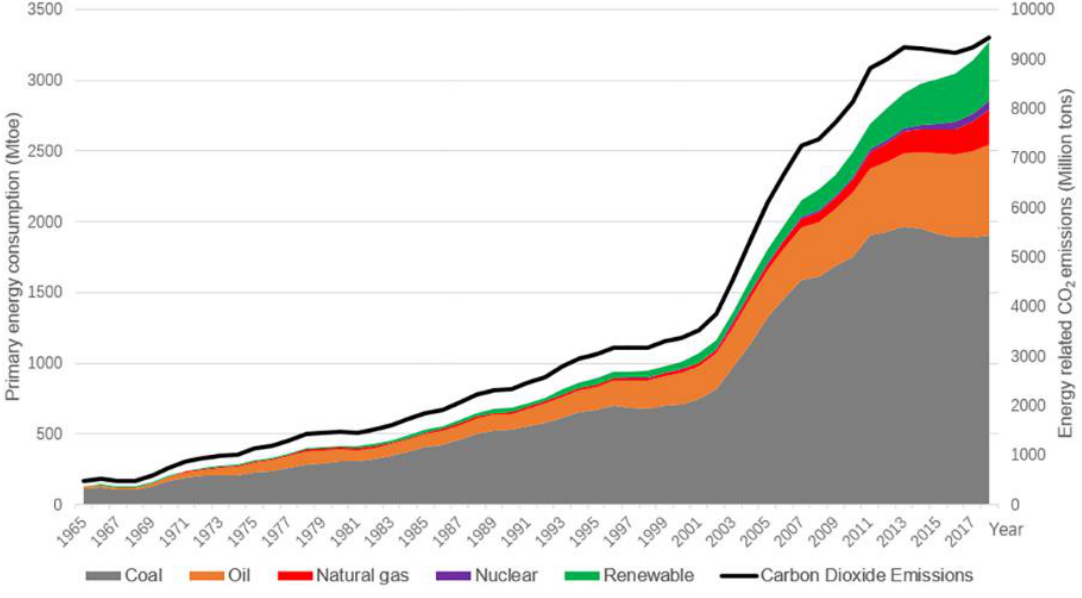
Figure A1. China’s primary energy consumption and energy-related CO 2 emissions in 1965–2018, data from BP statistics [13] (the renewable energy includes hydroelectricity).